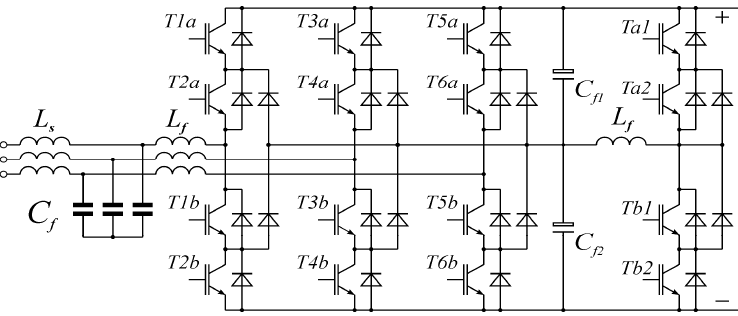
Figure 3. A three-level NPC inverter with autonomic voltage balancing on capacitors C f 1 and C f 2 .